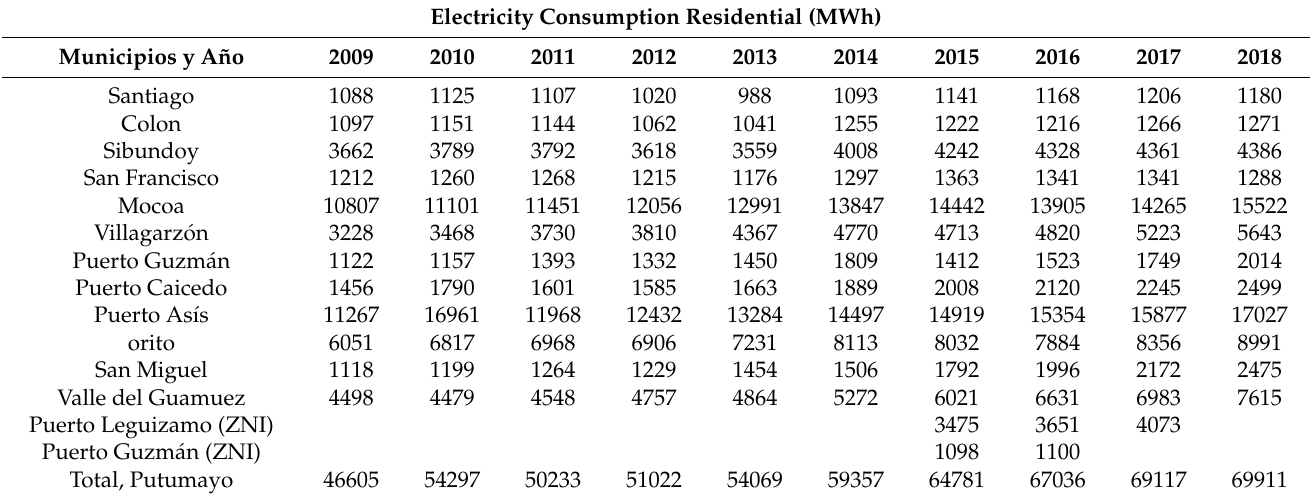
Table 9. Residential consumption of the areas connected to the national electricity grid and the ZNI in the department of Putumayo.